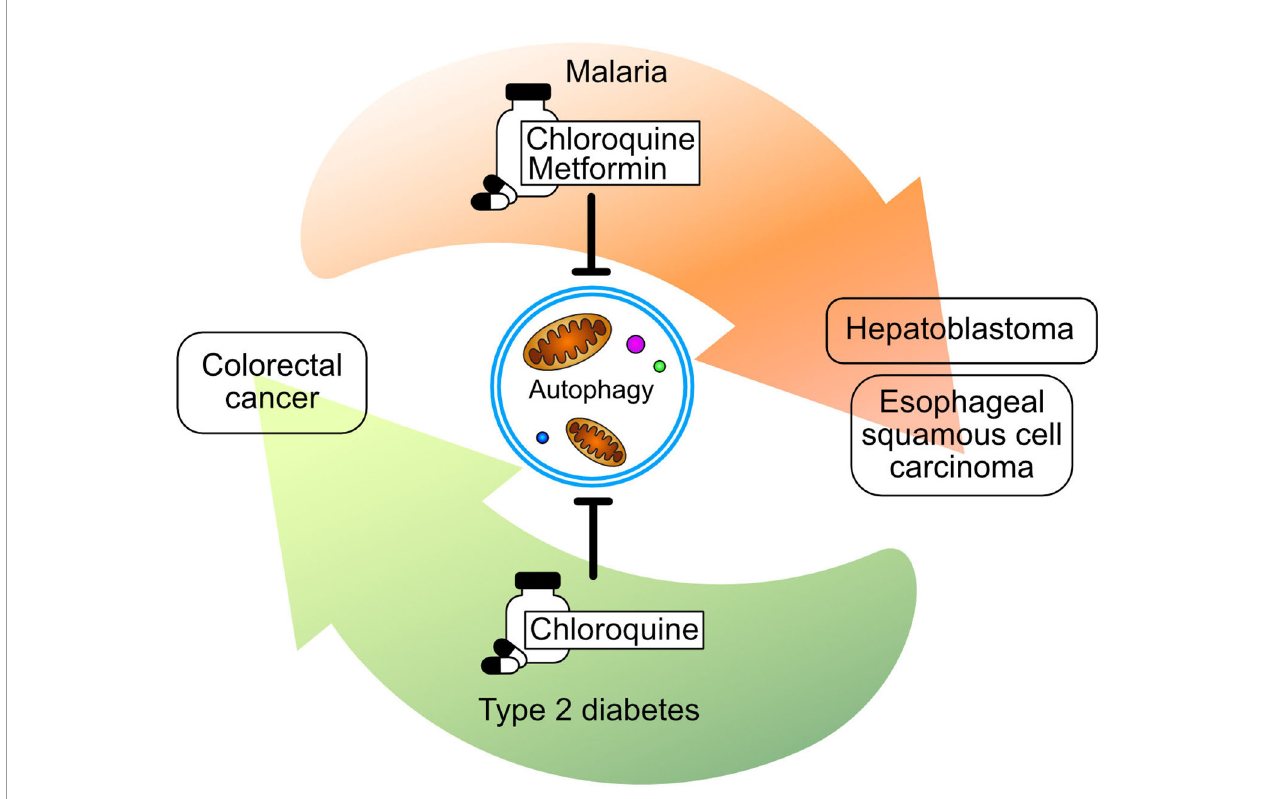
FIGURE 1 | Inhibition of autophagy was a prevalent subject matter in the papers submitted to this research topic. Drugs with this effect, such as Metformin and Chloroquine, can be repurposed from malaria and type-2 diabetes to treat colorectal cancer, hepatoblastoma, and esophageal squamous cell carcinoma. Background arrows indicate the direction of drug